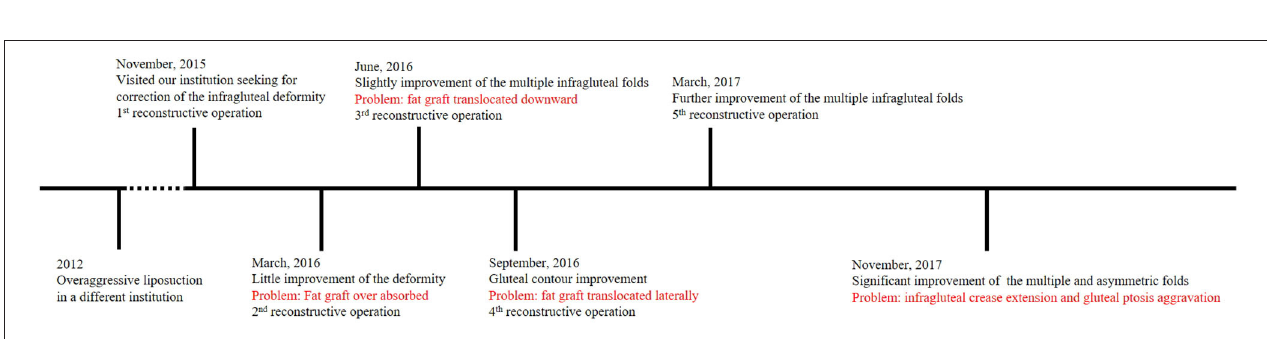
FIGURE 3 | was improved and the convex deformity caused by fat downward translocation was corrected. The arrow indicates the lateral translocation of fat. (D) Postoperative view of the patient 6 months after the 4th reconstructive operation. The multiple infragluteal folds were further improved to a small extent. (E)